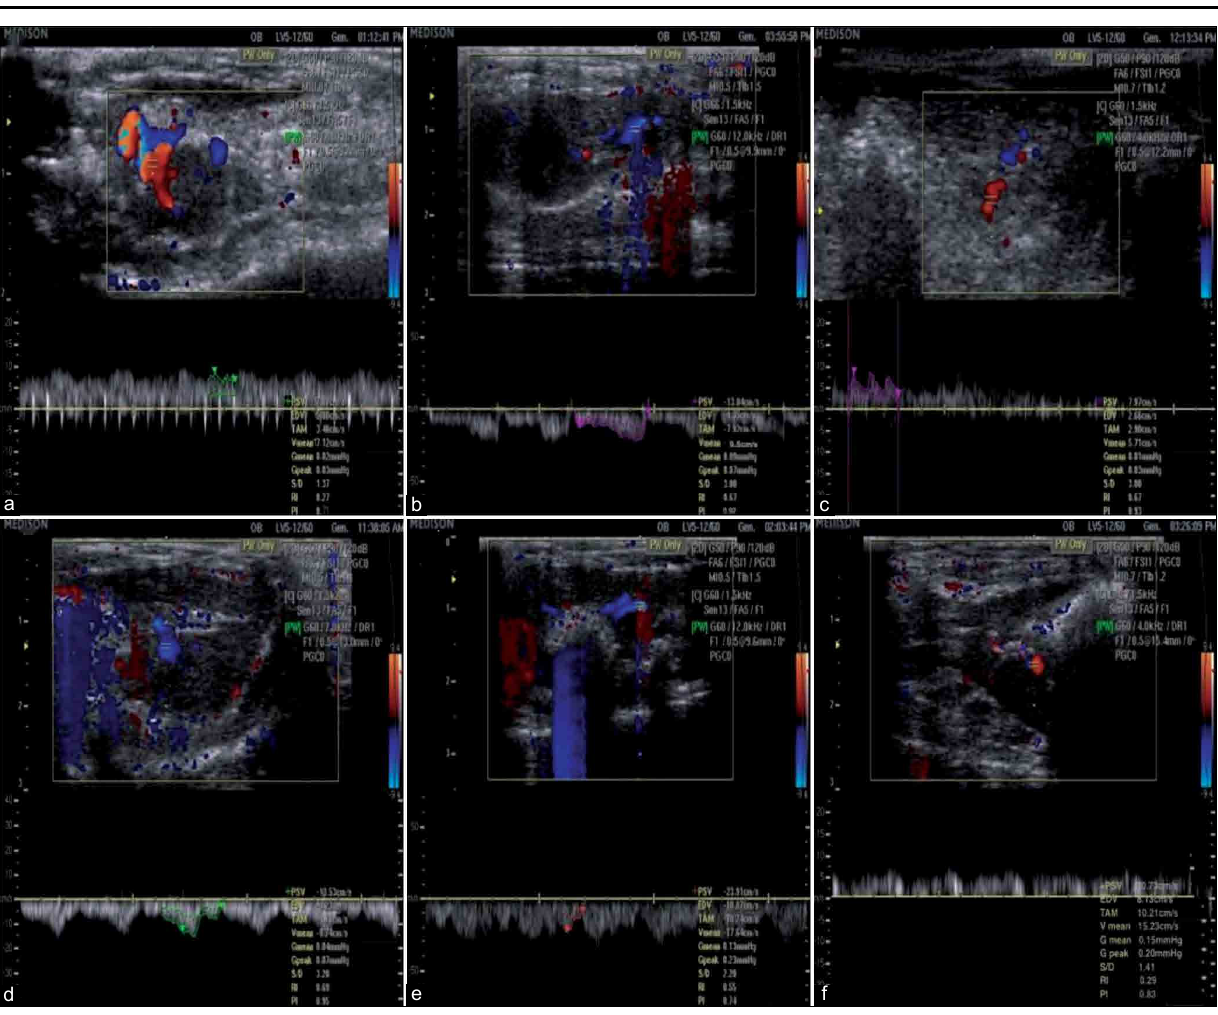
Figure-9: Color and spectral Doppler ultrasonography portal vein waveforms. (a) Portal vein of healthy control rats showing continuous hepatopetal flow toward the liver demonstrated in red on the color Doppler sonogram and antegrade flow above the baseline in the spectral waveform with normal V mean (17.12 cm/s) and moderate PI (0.71). (b) Portal vein of Toxocara vitulorum- rat model showing slow, hepatofugal flow away from the liver as blue in the color Doppler sonogram and as retrograde flow below the baseline in the spectral waveform with low V mean (4.3 cm/s) and PI (1.74). (c) Portal vein at the 2 nd week following albendazole treatment showing hepatopetal flow toward the liver as red in the color Doppler sonogram and antegrade above the baseline in the spectral waveform with low V mean (5.71 cm/s) and PI (0.93). (d) Portal vein at the 4 th week following albendazole treatment showing hepatofugal flow away from the liver as blue in the color Doppler sonogram and retrograde flow below the baseline in the spectral waveform with low V mean (9.74 cm/s) and PI (0.95). (e) Portal vein at 2 nd week after albendazole treatment with BMMSCs transplantation showing slow hepatofugal flow away from the liver as blue in the color Doppler sonogram and retrograde flow below the baseline in the spectral waveform with normal V mean (17.46 cm/s) and mild PI (0.74). (f) Portal vein at 4 th week after albendazole treatment with BMMSCs transplantation showing hepatopetal flow toward the liver as red in the color Doppler sonogram and antegrade flow above the baseline in the spectral waveform with mildly V mean (15.23 cm/s) and moderate PI (0.83). V=Velocity, PI=Pulsatility index, BMMSCs=Bone marrow mesenchymal stem